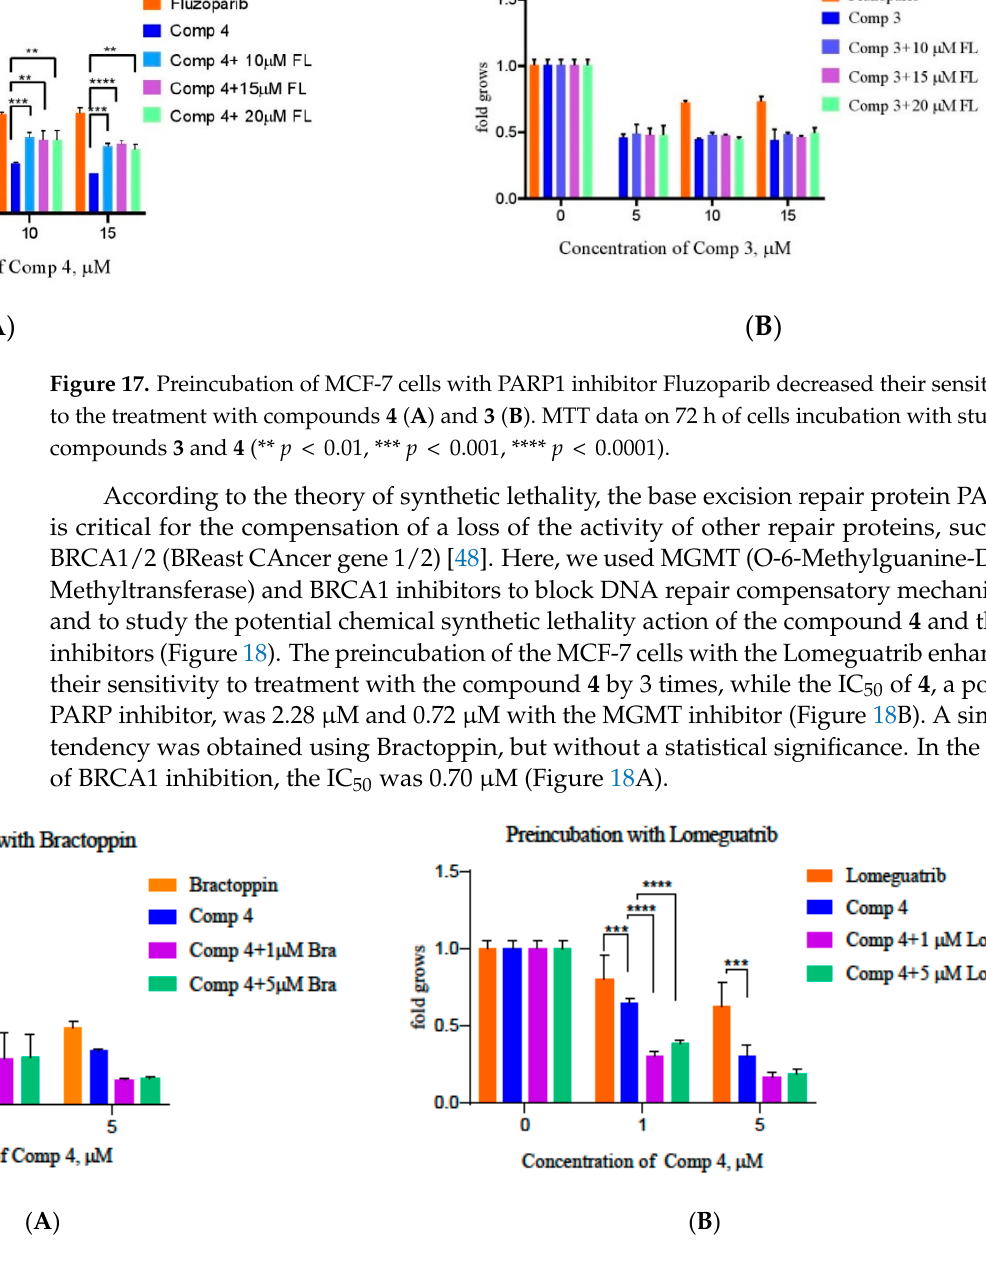
Figure 18. Chemical synthetic lethal interactions between PARP1 inhibition by the compound 4 , and BRCA1 ( A ), MGMT ( B ) inhibition. MTT data, 72 h of incubation (*** p < 0.001, **** p < 0.0001).